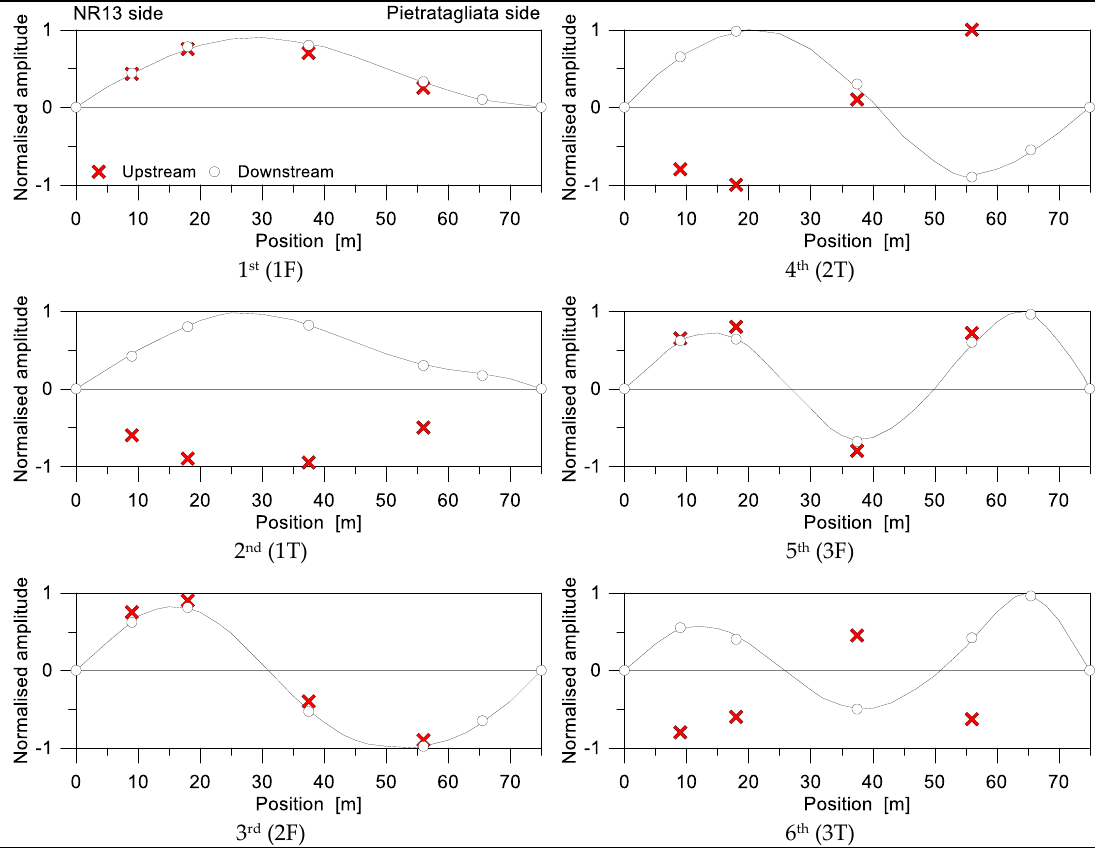
Figure 8. EMA vibration modes (normalised amplitudes), as obtained from MEMS measurements and SMIT post-processing [46].